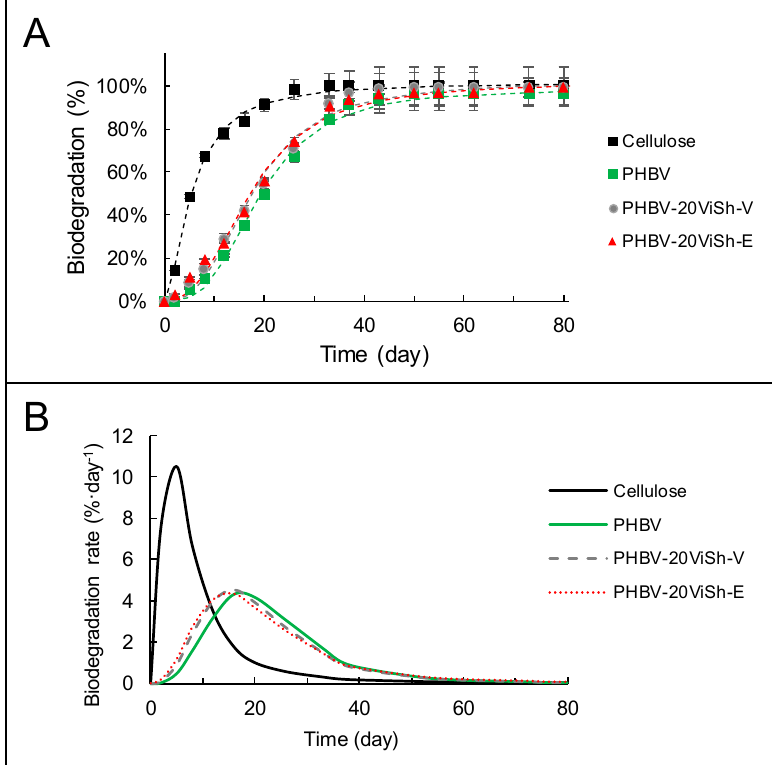
Figure 5. Kinetic of biodegradation ( A ) and biodegradation rate ( B ) of PHBV-based composites in soil.